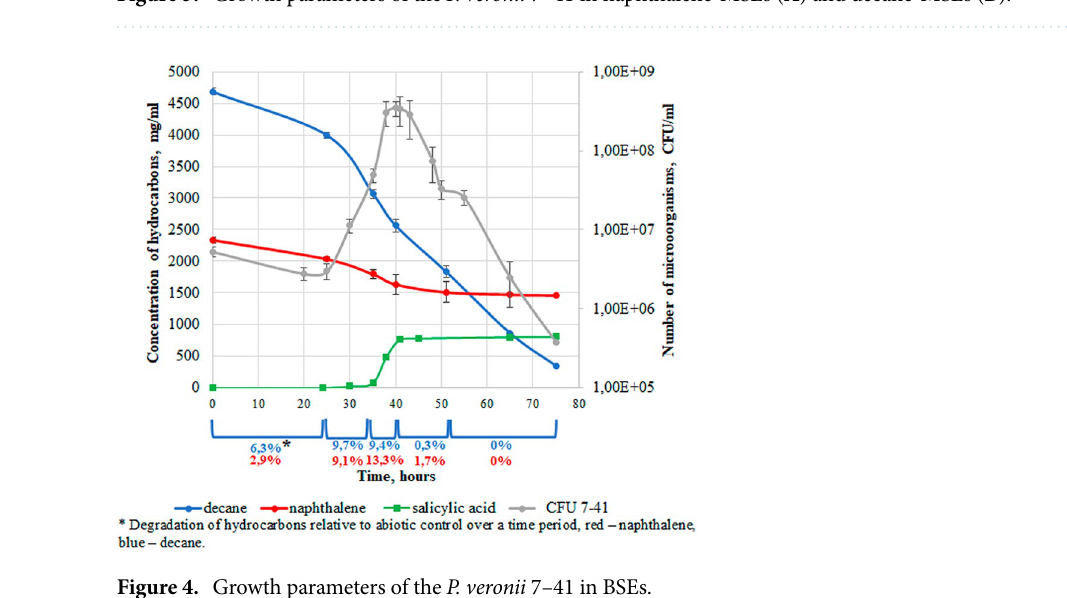
Figure 3. Growth parameters of the P. veronii 7–41 in naphthalene-MSEs ( A ) and decane-MSEs ( B ).